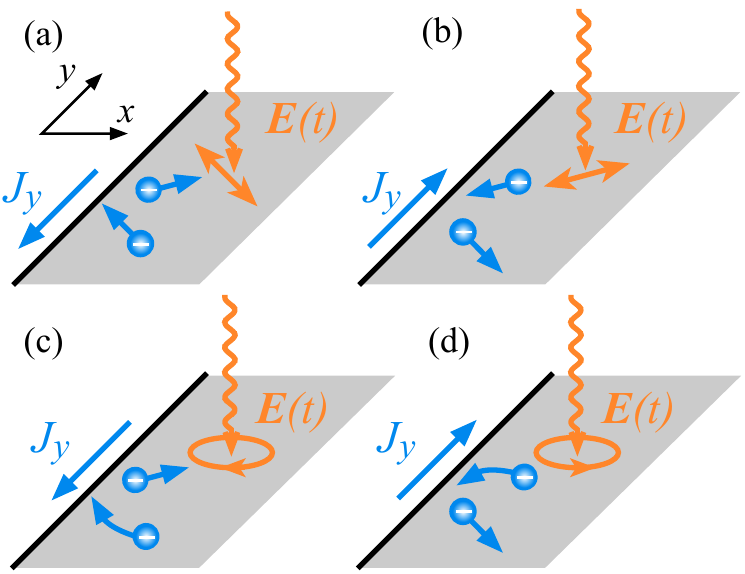
Figure 1. Illustration of the edge current formation. The back-and-forth motion of 2D carriers occupying the x ≥ 0 half-plane by linearly polarized ( a , b ) or circularly polarized ( c , d ) AC electric field results, due to electron scattering from the edge and dynamical charge accumulation, in the DC current J y flowing along the edge. The edge current direction is controlled by the field